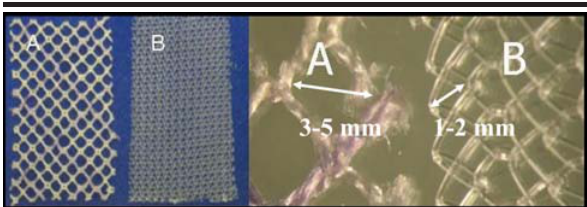
FIGURE 1 - Macroscopic (left) and microscopic comparison with 16x enlargement (right) of the Vypro® (A) and polypropylene (B)